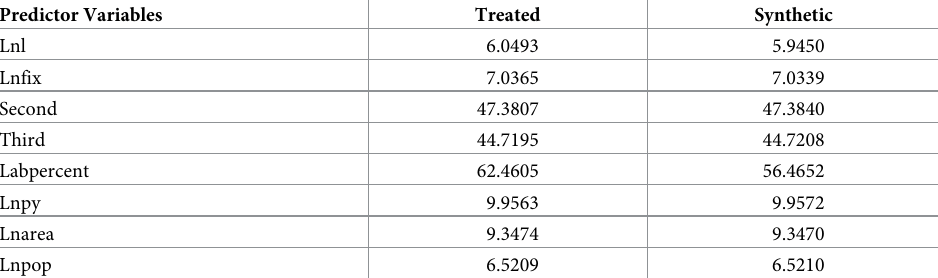
Fig 10. Prediction error distribution of DO for Hefei. https://doi.org/10.1371/journal.pone.0257067.g010 Table 9. Comparison of the treated and synthetic predictors of Log (GDP).